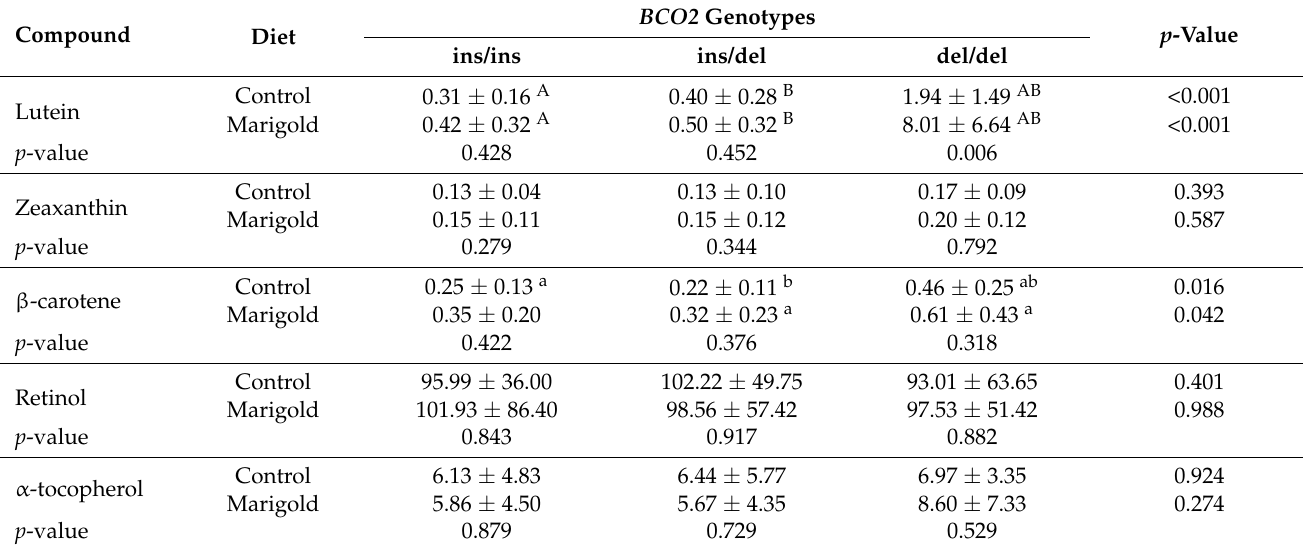
Figure 3. Relative BCO1 , BCO2 , LRAT , and TTPA mRNA levels in the liver of rabbits with the del/del genotype at codon 248 of the BCO2 gene, fed different diets (control diet vs. a diet with the addition of Aztec marigold flower extract). GAPDH and β -actin were used as reference genes. Data represent posterior means (expressed as arbitrary units) ± 95% credible intervals. Means followed by the same superscripts (A, A) differ highly significantly ( p ≤ 0.01). Table 1. Content of selected compounds in the liver ( µ g/g) of rabbits (mean ±